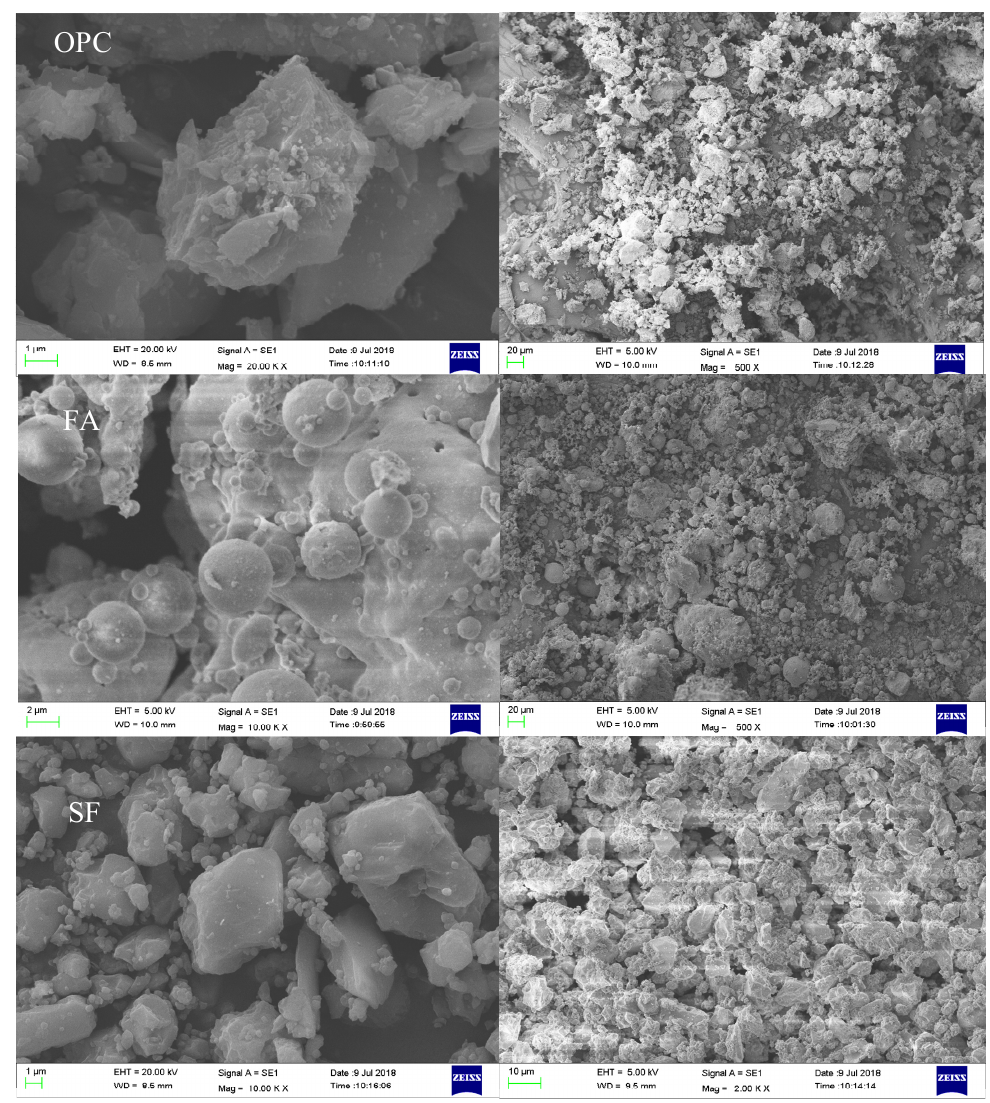
Figure 2. SEM morphology of OPC, FA, and SF.